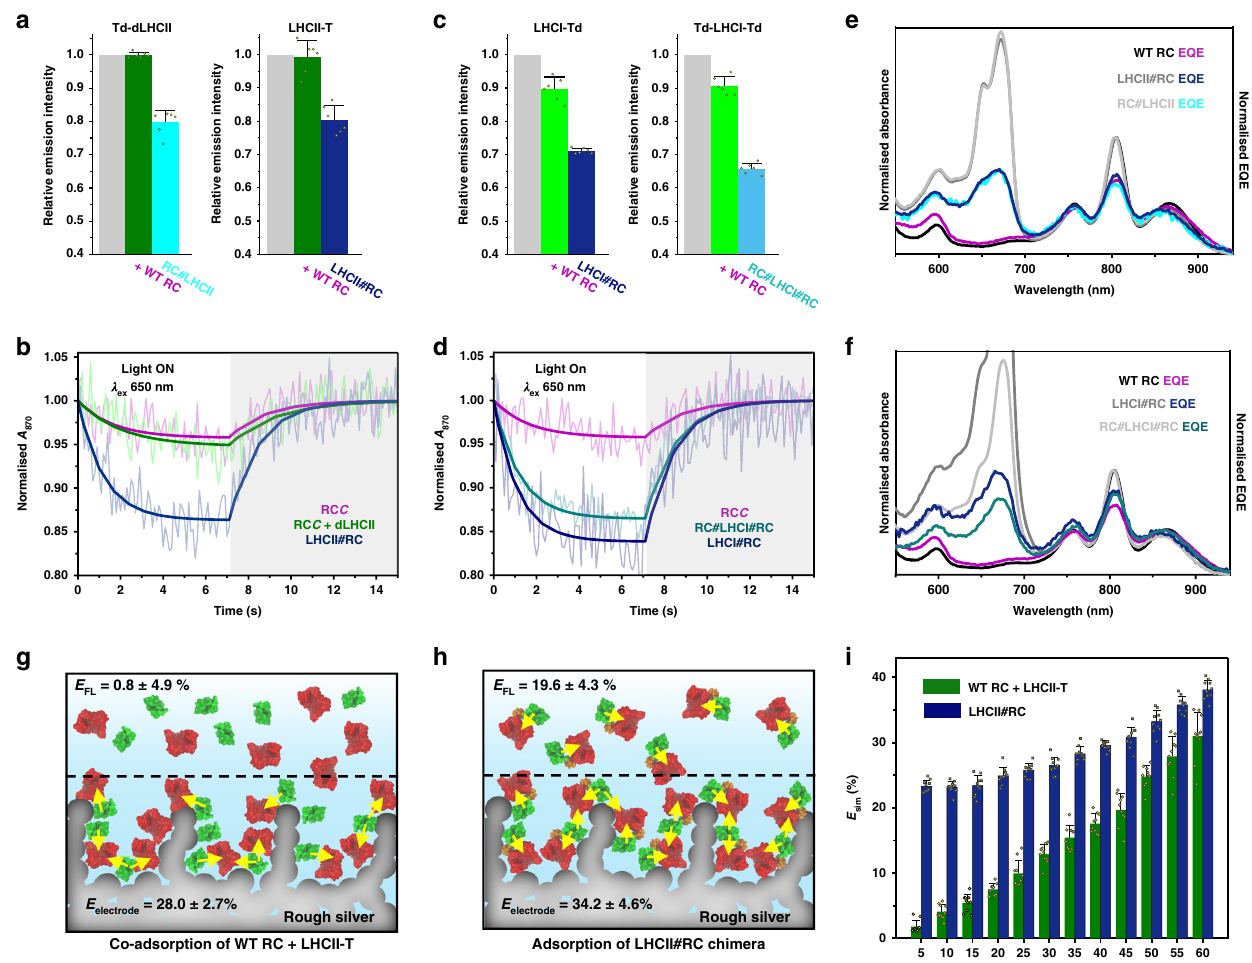
Fig. 4 Energy transfer in chimeras in solution and on surfaces. a Emission at 682 nm from (left) the Td-dLHCII protein alone (grey), after addition of a twofold excess of WT RCs (green) and in a LHCII#RC chimera (cyan) formed on mixing with a twofold excess of RC C , and (right) equivalent data for LHCII-T. b Data and fi ts for photobleaching and dark recovery of P870 absorbance in RC C , a 1:1 RC C plus dLHCII mixture and the LHCII#RC chimera. c Emission from (left) LHCI-Td alone (grey), after addition of a threefold excess of WT RCs (green) and in a LHCI#RC chimera (navy) formed on mixing with a threefold excess of RC C , and (right) equivalent data for Td-LHCI-Td. Error bars in a and c represent standard deviations from six repeats (three technical repeats of two biological repeats) and data points are shown as overlaid circles. d Data and fi ts for photobleaching and dark recovery of P870 absorbance in RC C and the two RC-LHCI chimeras. e Solution absorbance and EQE spectra for WT RCs compared with those for the two LHCII-RC chimeras. f Solution absorbance and EQE spectra for WT RCs compared with those for the two RC-LHCI chimeras. g Schematic of adsorption of independent RC (red) and LHCII (green) complexes on an electrode. Yellow arrows indicate possible energy transfer connections. h Equivalent schematic of adsorption of RC#LHCII chimeras. i Simulated apparent ET ef fi ciencies as a function of packing density for independent RC and LHCII proteins or the LHCII#RC chimera. Error bars represent standard deviations from ten simulation repeats. Individual data points are represented by circles or